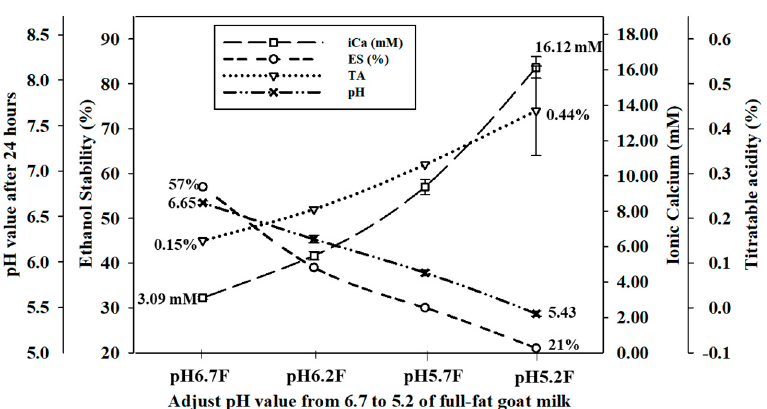
Figure 2. The effect of pH adjustment of full-fat Alpine goat milk on pH value after 24 h, titratable acidity (TA), ionic calcium concentration (iCa), and ethanol stability (ES).